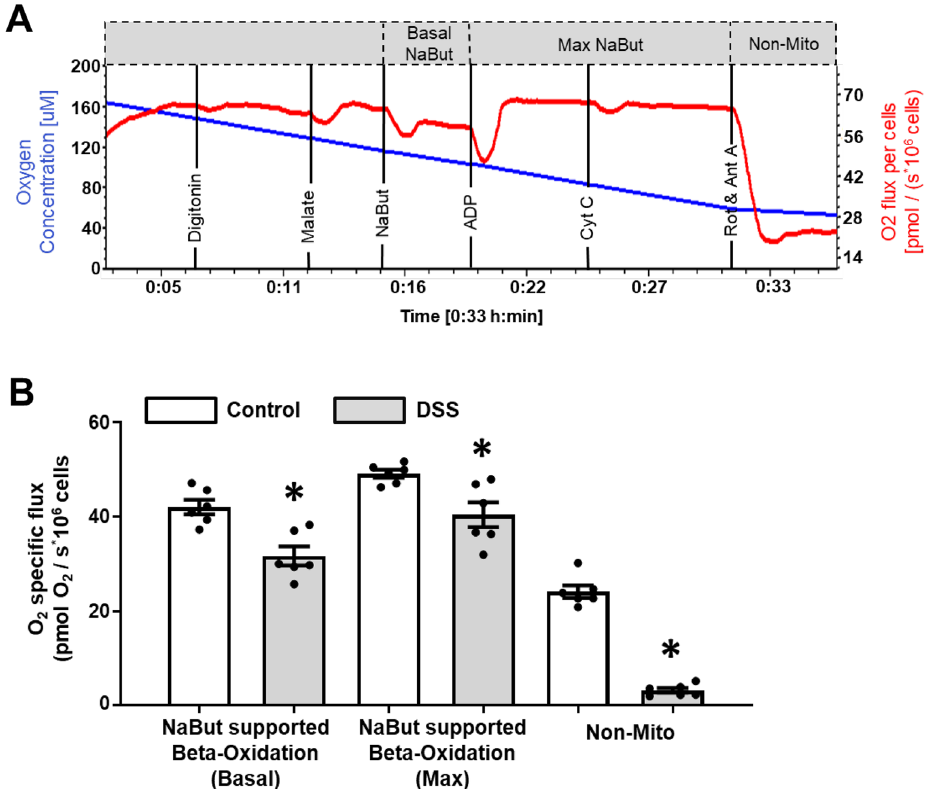
Figure 3. Examination of butyrate supported beta-oxidation in permeabilized IEC 4.1 cells (10 6 cells/mL) in the Oroboros O2k analyzer treated under control (white bars) or DSS (gray bars) conditions. ( A ) Oroboros O2k representative tracing of control IEC 4.1 cells during the developed butyrate beta-oxidation protocol. Black vertical lines indicate additions of substrates/inhibitors/uncouplers. Malate (0.1 mM), NaBut: sodium butyrate (2 mM), ADP: adenosine diphosphate (2.5 mM), Cyt C: cytochrome c (10 µM), Rot: rotenone (0.5 µM), Ant A: antimycin A (2.5 µM). Gray hatched boxes represent different respiratory states: Basal NaBut (basal butyrate supported beta oxidation), Max NaBut (maximal butyrate supported beta oxidation), and non-mitochondrial respiration (Non-mito). ( B ) Mitochondrial-specific O 2 flux responses after the addition of beta-oxidation linked substrates (malate, sodium butyrate) and mitochondrial inhibitors (non-mitochondrial respiration; rotenone, antimycin. Data is presented as mean ± SEM (n = 6 replicates from 2 independent experiments; *Represents significant differences between the control group, p < 0.05; two-tailed independent t-tests for each respiratory